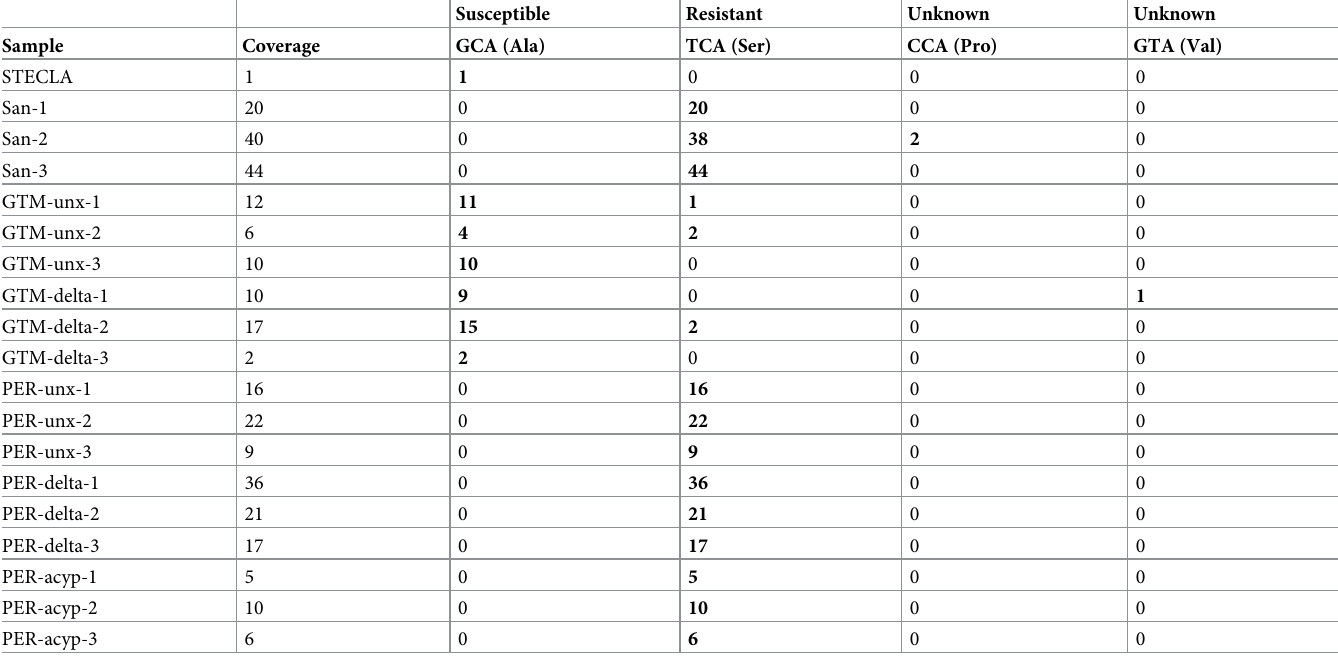
Table 5. Codons present in RNAseq reads at position ‘296’ of the GABA gated chloride channel A subunit